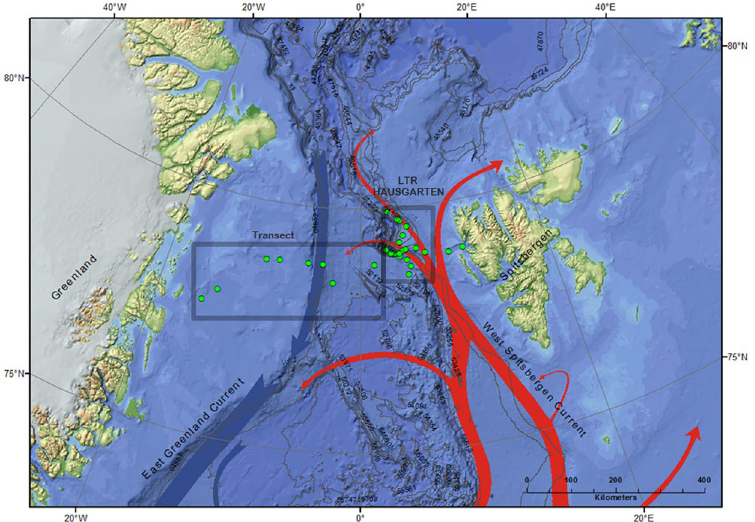
Figure 1. Map of the study area in the Fram Strait (Arctic Ocean), with the LTER (Long-Term Ecological Research) HAUSGARTEN observatory visited in 2009–2012 and 2014, as well as the transect stations sampled in 2014. The map was created using ArcGIS 10.3 and based on the General Bathymetric Chart of the Oceans (GEBCO)-08 grid, version 20100927, http://www.gebco.net, with permission from the British Oceanographic Data Centre